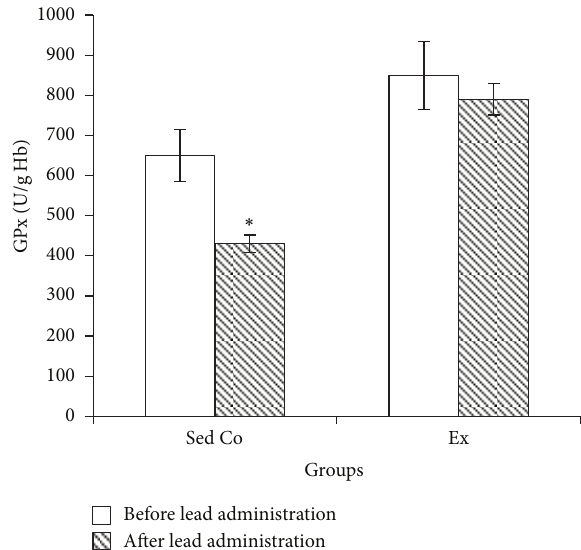
Figure 2: Blood glutathione peroxidase in sedentary control and exercise groups before and after lead administrations. Seven days of lead injections (15mg/Kg body weight, ip) to sedentary animals housed in the regular cages caused significant reduction of blood GPx ( ∗ 𝑃 < 0.05 compared to the “before lead administration”); in Ex animals housed in the wheel equipped cages, GPx changes after thesamedoseleadadministrationswerenotsignificant.Thedataare presented as means ± S.E.M. GPx: glutathione peroxidase; Sed Co: sedentary control group; Ex: exercise group.